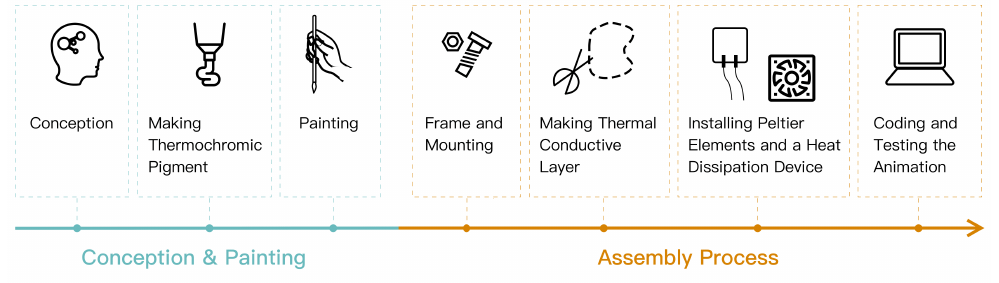
Figure 3. The process in the art practice of “Nine